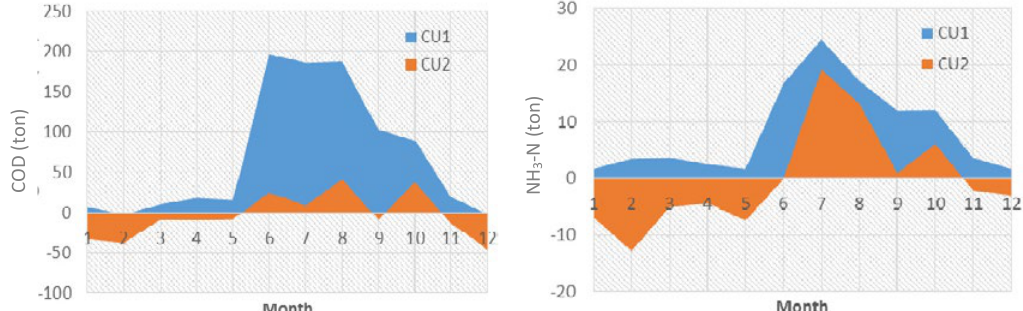
Fig. 10 : Surplus dynamic water environmental capacity of COD and NH Fig. 10: Surplus dynamic water environmental capacity of COD and NH 3 -N at Control Unit 1 and 2